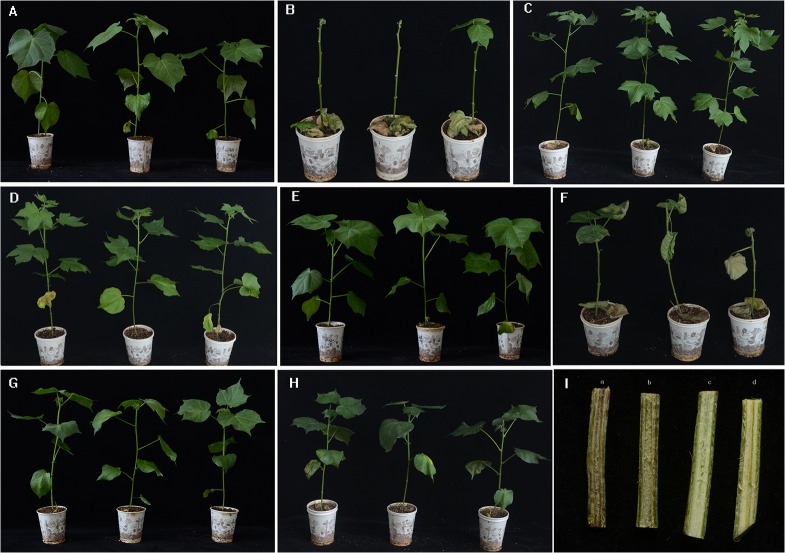
Plant symptom of 35th day inoculated by Verticillium dahliae isolates V991.A, Junmian 1 (non-inoculation,Verticillium-sensitive control); B, Junmian 1 (inoculated, severe diseased); C, Shixiya 1 (non-inoculation); D, Shixiya 1 (inoculated, high resistant); E, TM-1 (non-inoculation); F, TM-1 (inoculated, severe diseased); G, S1 (non-inoculation); S1, (inoculated, resistant); I, Symptom in the vascular in cotton stems (a, Junmian 1, dark brown vascular tissue; b, TM-1, dark brown vascular tissue; c, Shixiya 1, clear vascular tissue; d, S1, near clear vascular tissue).